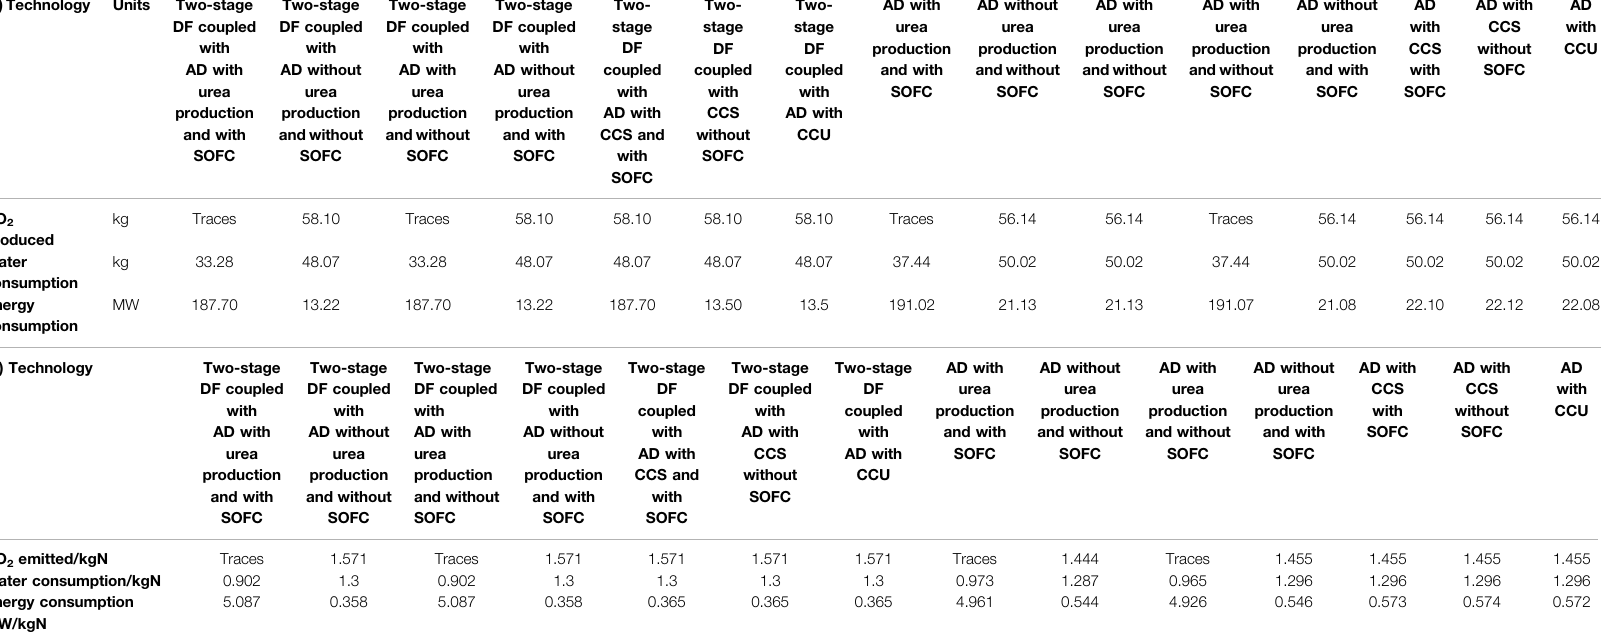
TABLE 3 | A comparison of the modeling results of the proposed processes for a 20 tpd waste facility in terms of CO 2 emissions, water, and energy consumption (A) daily basis and (B) per kg utilized-N. (A)Technology Units Two-stage